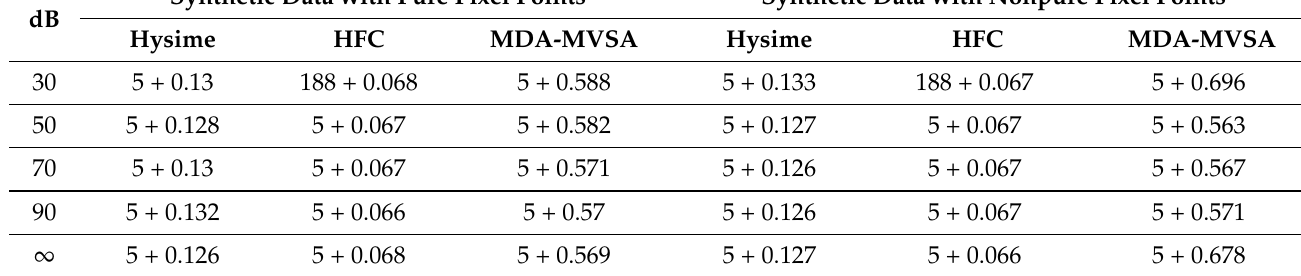
Table 5. The results of estimated number of endmembers + the processing time by different methods on synthetic data containing pure and nonpure mineral signatures under different noise levels. The two types of synthetic data both have 2000 pixel points and five endmembers.